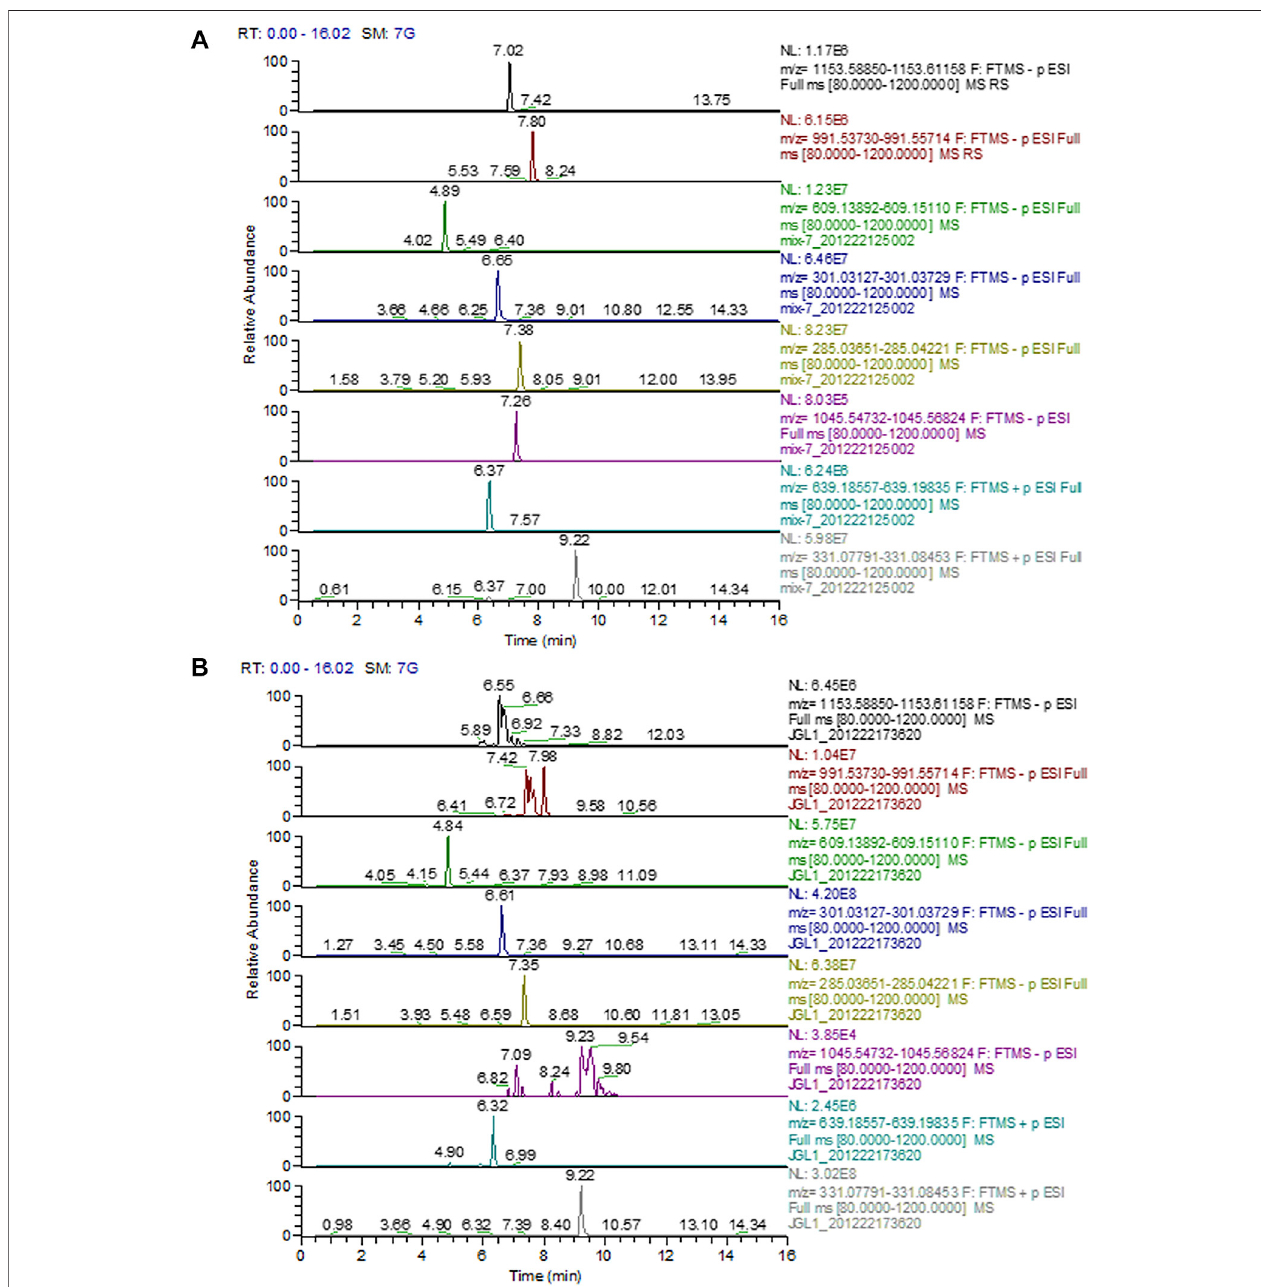
FIGURE 1 | Representative full-scan chromatograms of (A) Standard solutions; (B) Sample solution: ginsenoside Rb1 (6.92 min), ginsenoside Rd (7.98 min), rutin (4.84 min), quercetin (6.61 min), kaempferol (7.35 min), gypenoside XLIX (7.26 min), ombuoside (6.32 min), and ombuin (9.22 min).